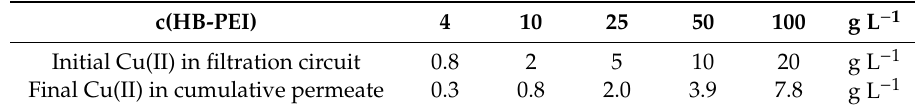
Table 7. Final Cu(II) concentration in cumulative permeate collected during polymer regeneration and rinsing of the filtration circuit with water. No Cu(II) retention and 90% discharge ( Ѳ = 2.3) are assumed. Calculation according to Equation (3) and by mass balancing.